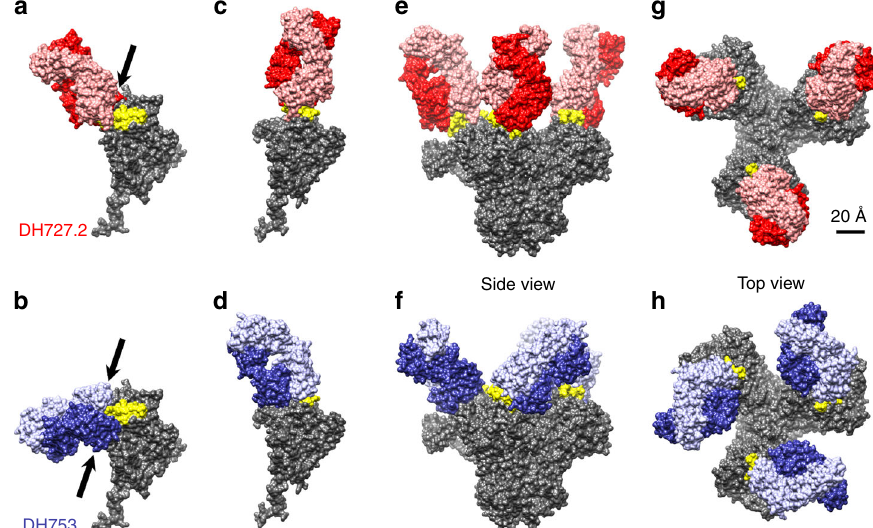
Fig. 6 Molecular models predict that DH753 and DH727.2 interact with trimeric HIV-1 Env in the open conformation. a – d Docking DH727.2 and DH753 onto to a single gp120 from a closed envelope trimer (PDB: 4ZMJ, https://www.rcsb.org/structure/4ZMJ) indicates clashes, marked by arrows where the polypeptide chains overlap ( a , b ); whereas docking onto a CD4-induced, open gp120 monomer (PDB: 5VN3 https://www.rcsb.org/structure/5VN3) does not show any clashes ( c , d ). e – h The open trimer can accommodate three copies of either Fab, as shown in the side view ( e , f ) and top view ( g , h ). Colors are the same as in Figure 5, red/salmon indicate DH727.2, lilac/purple represent DH753, yellow shows the distal end of the V3 loop (residues 301-323), and gray depicts gp120/gp41. The scale is equal in all